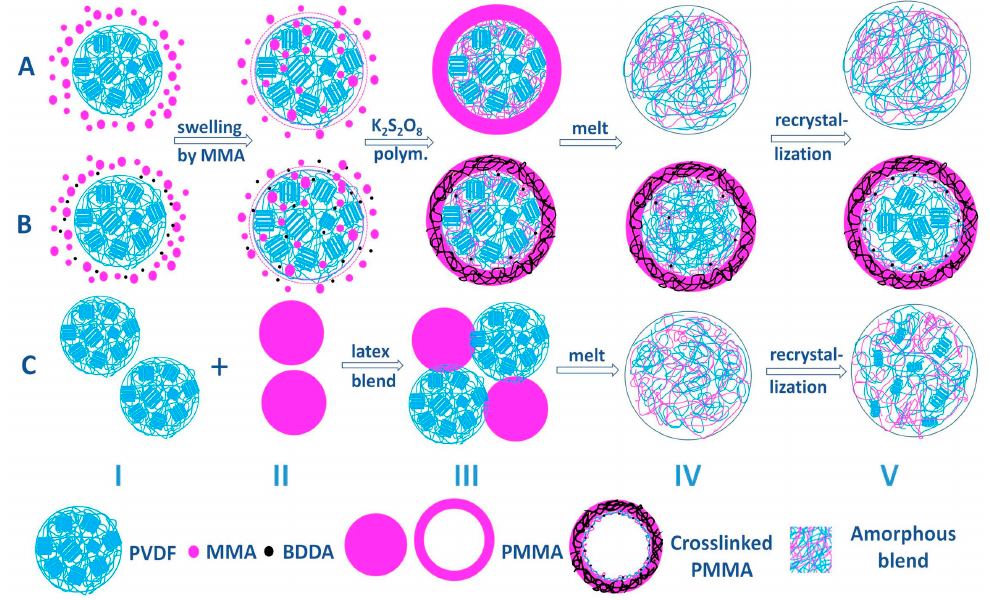
Figure 9. Schematic of the preparation of latex blends and their structure evolution during melt and re-crystallization: ( A ) PVDF@PMMA; ( B ) PVDF@c–PMMA; and ( C ) PVDF/PMMA. re-crystallization: ( A ) PVDF@PMMA; ( B ) PVDF@c–PMMA; and ( C )